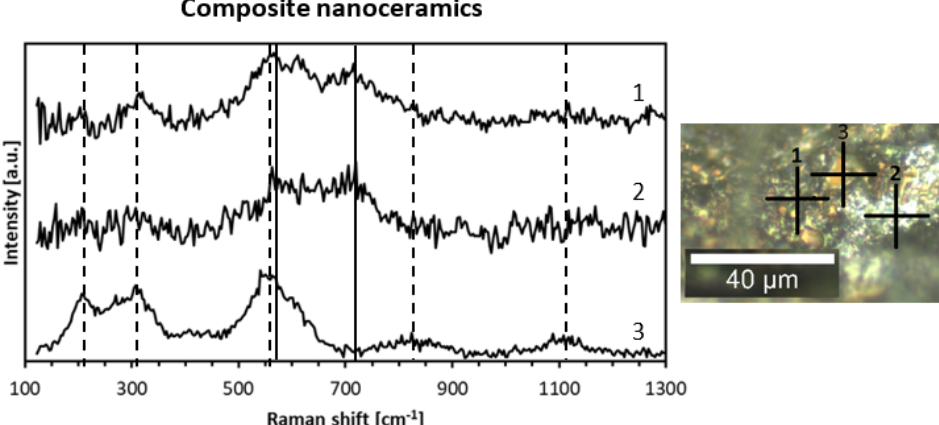
Figure 8. Raman spectra ( left ) for nanoceramics of Composite_800_sint_1000 at points 1–3 ( right ). Vertical lines are shift positions for various modes of TiN (dashed) and GaN (solid) and serve as guides for the eye, only.